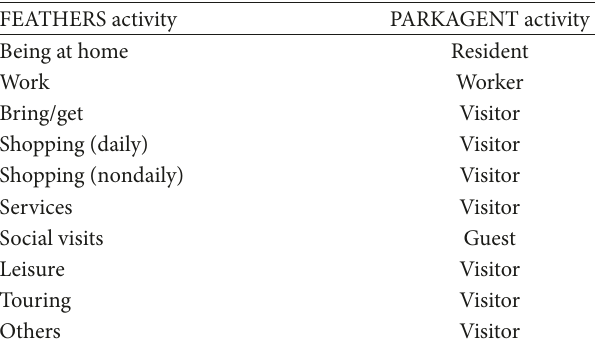
Table 2: Activity translation table. FEATHERS